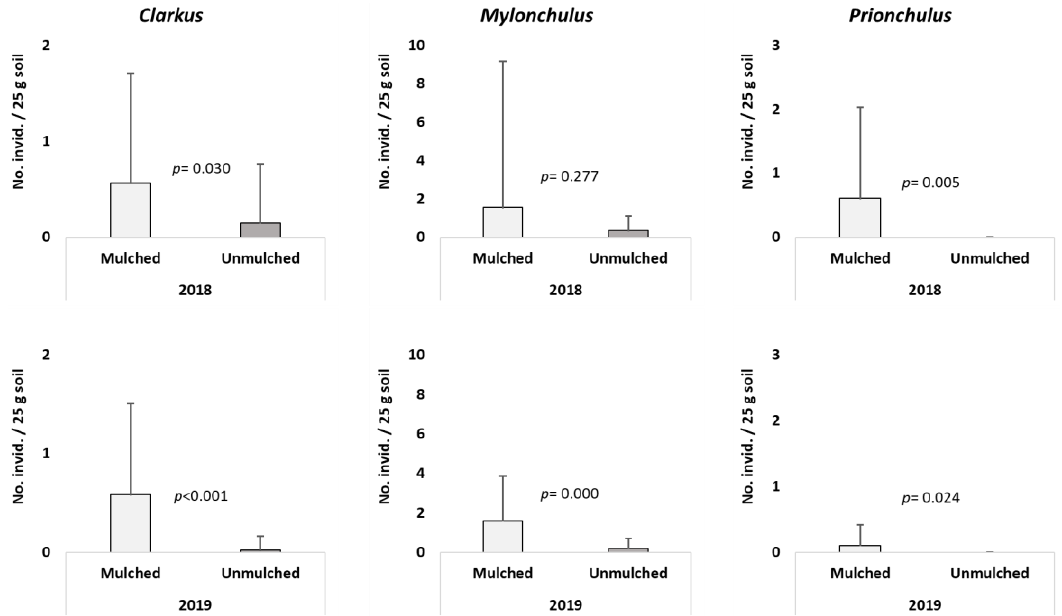
Figure 3. Numbers of mononchid individuals in mulched vs. unmulched open-field tomato plots in four consecutive experimental years. Gödöll˝o, Hungary. (Two sample T test).